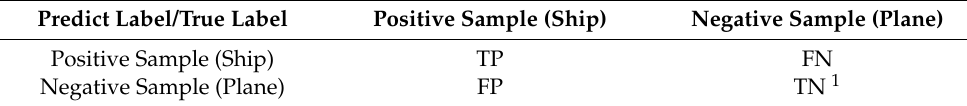
Table 1. Confusion matrix for binary classification of model ships and airplane. Predict Label/True